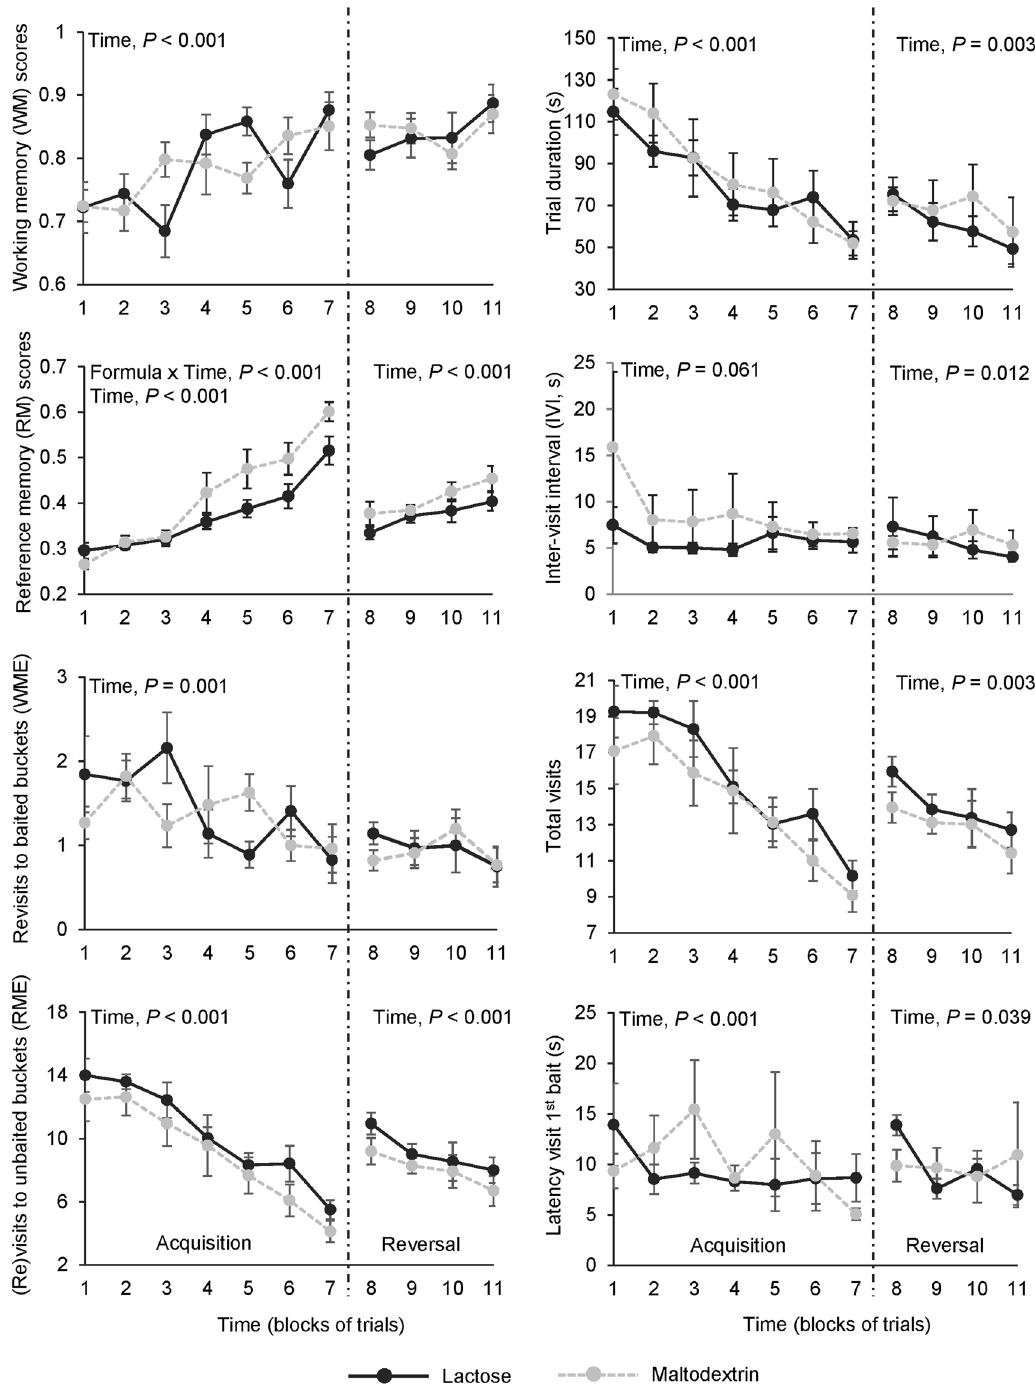
Figure 3. Performance of piglets fed either a lactose-based formula or a maltodextrin-based formula from 1 to 9 weeks of age, in the acquisition and reversal phases of a spatial holeboard task. Each block of trials ( i.e . time) represents the average of 4 consecutive trials. Data are expressed as means ± SEM and were analysed with a linear mixed